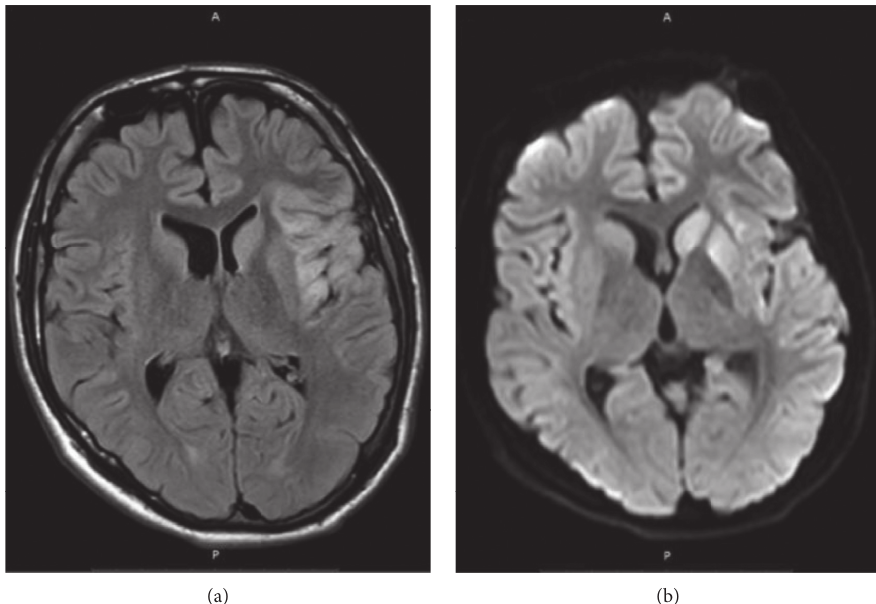
Figure 4: Brian MRI images of the patient, two weeks after neurological symptom onset. Axial (a) fluid-attenuated inversion recovery (FLAIR) MRI scans and (b) diffusion-weighted images (DWI) showing a hyperintense signal and edema of the caudate nucleus head, putamen, and parts of the external capsule and insula on the left